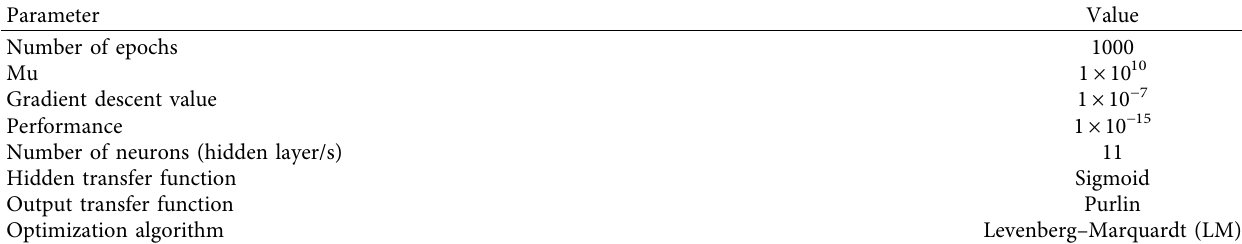
Figure 1: Architecture of an artificial neural network for one hidden layer. Table 3: Tuned parameters for